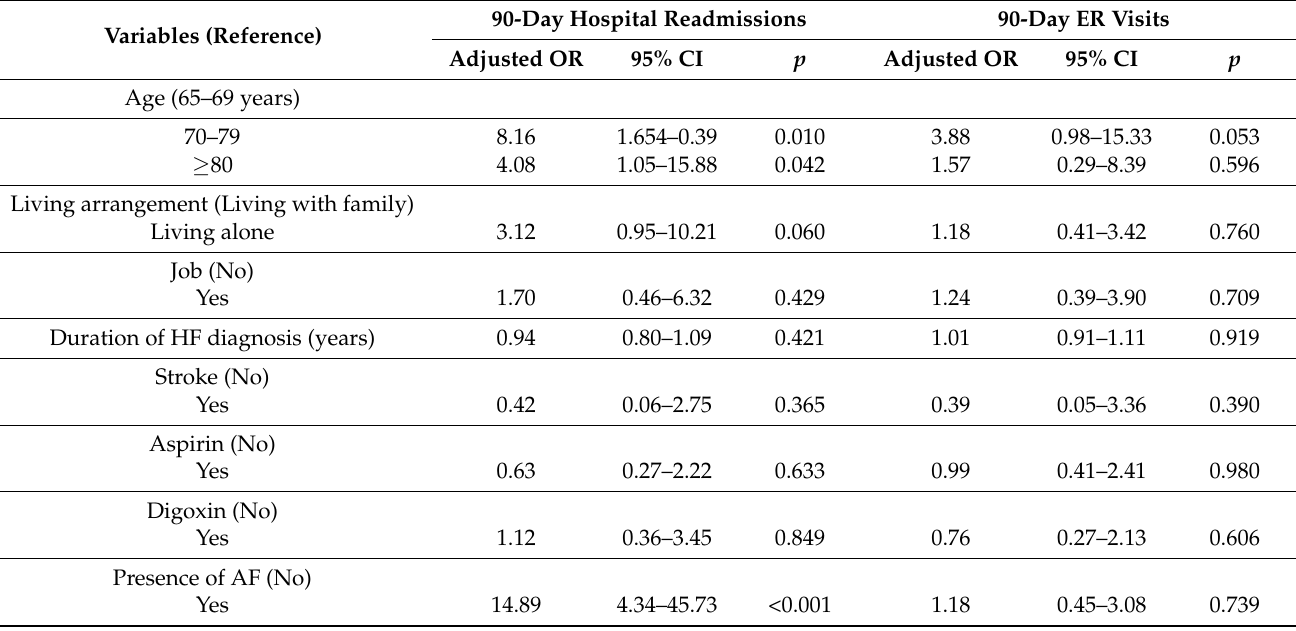
Table 3. Multivariate logistic regression analysis of 90-day hospital readmissions and ER visits in older male patients with HF ( n =